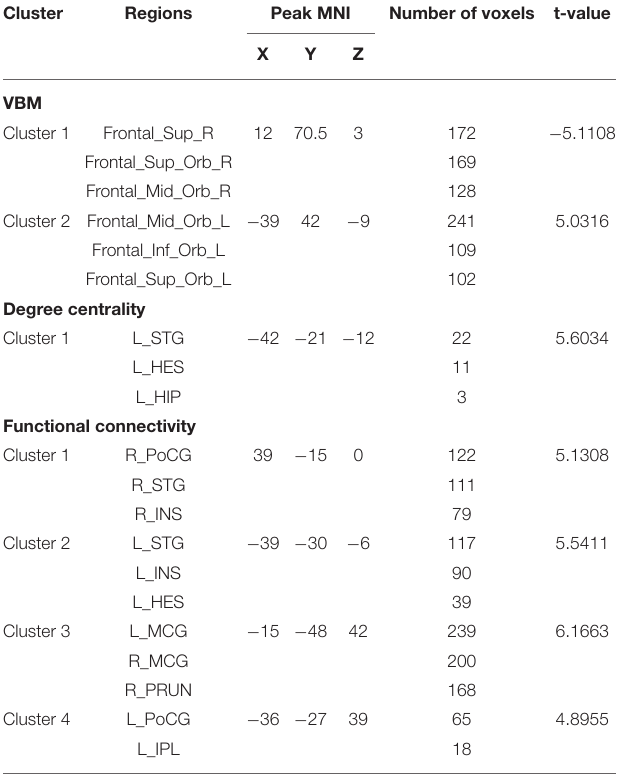
TABLE 2 | Comparison of GMV, DC, and FC between early-T2DM and HC groups. Cluster